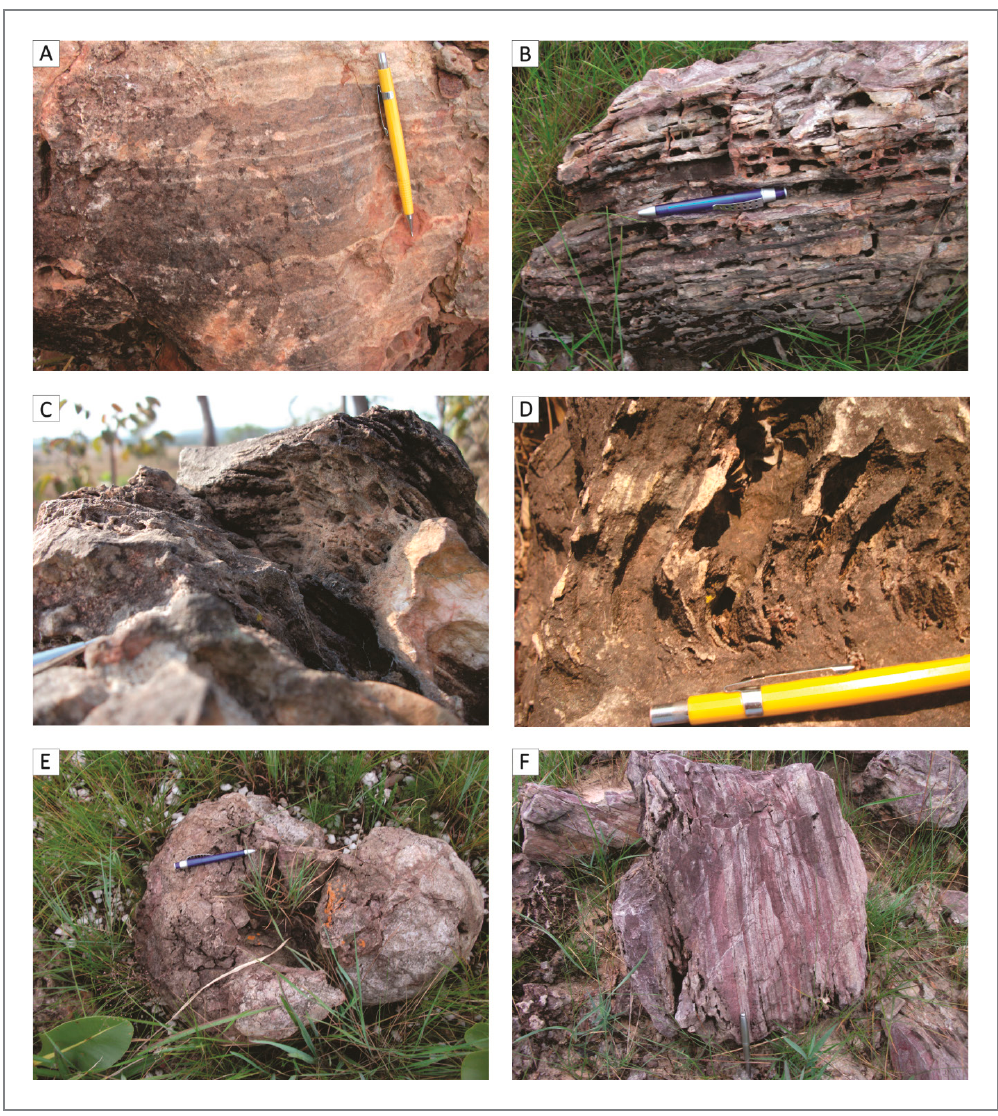
FIGURE 5 - Features of associated metachert outcrops. (A) Sharply banded metachert. (B, C, D) Banded cherty rock with a vuggy texture developed roughly parallel to the banding. (E) Siliceous globular structures as indicated by curved outlines. (F) Possible metachert layers (white) interbedded with red